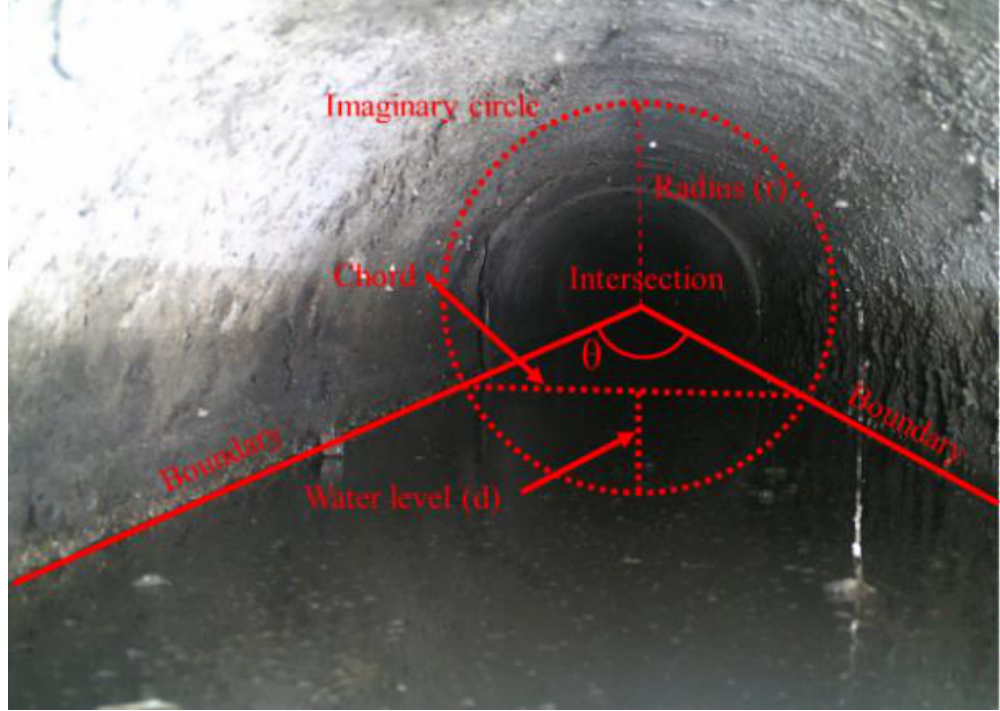
Figure 4. Geometric relationship between wastewater boundary line and water level.